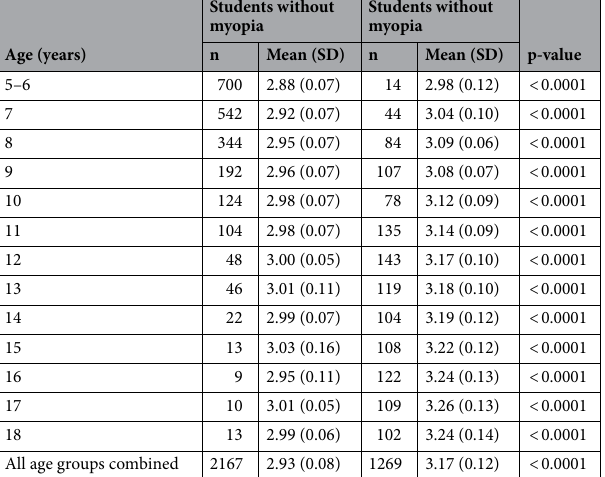
Table 4. Comparison of AL/CR ratio between students with and without myopia. AL/CR ratio axial length/ corneal curvature radius ratio, SD standard